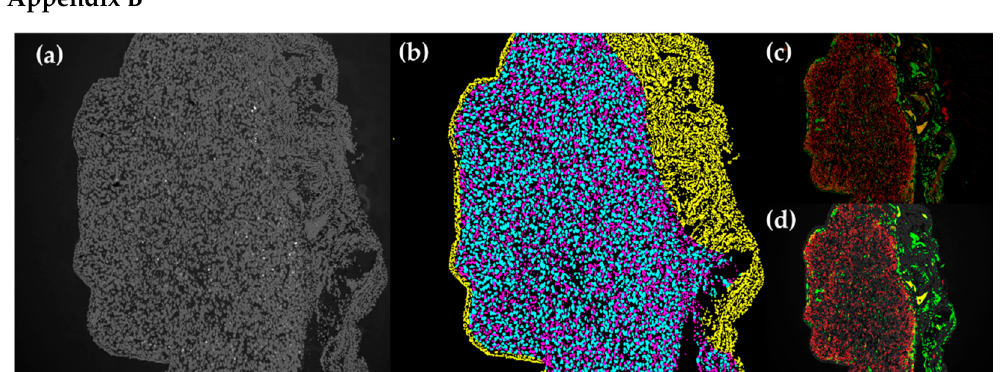
Figure A1. Classification of tissue categories in IF images. ( a ) Original DAPI image. ( b ) Cell labelling: cyan = human cells, yellow = chicken cells in the periphery of human tissue (CAM), magenta = chicken cells in the human tissue. ( c ) Original fluorescent images. ( d ) Segmented fluorescent images.